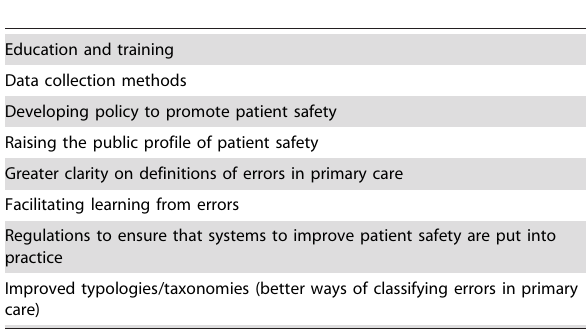
Table 6. Cross-cutting items that were considered to be im- portant to focus on by over 80% of participants after round